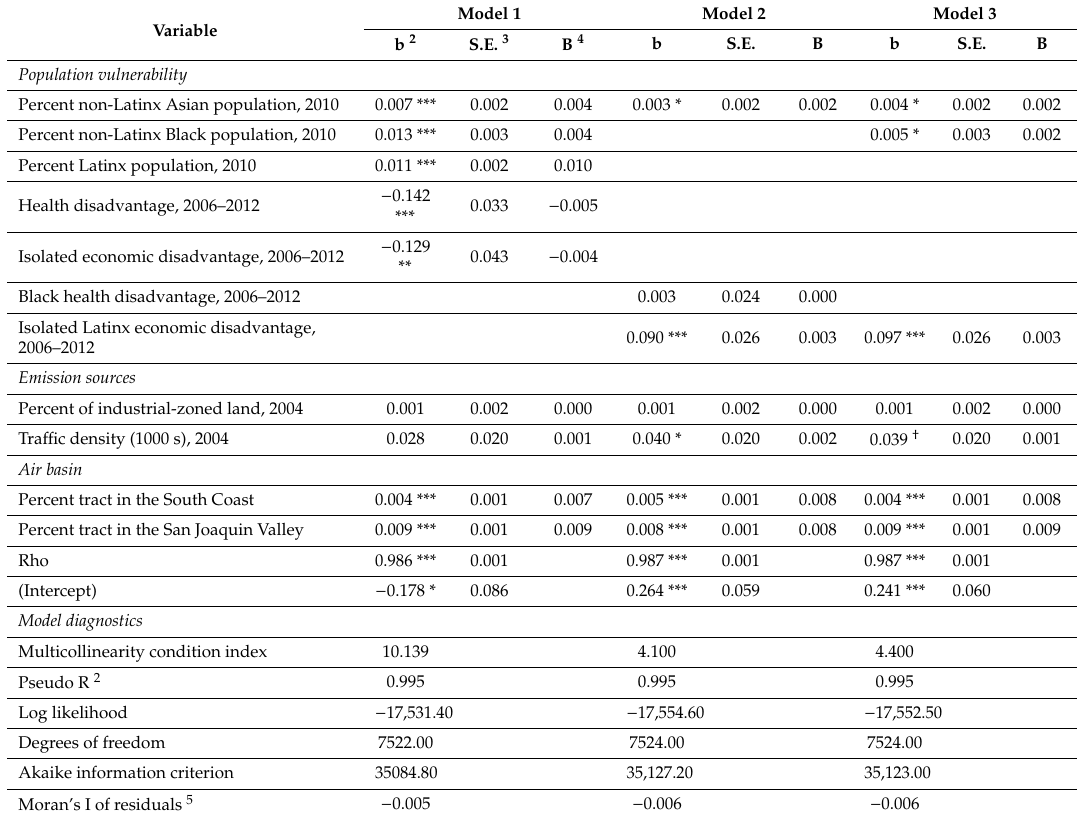
( N = 7533 tracts) 1